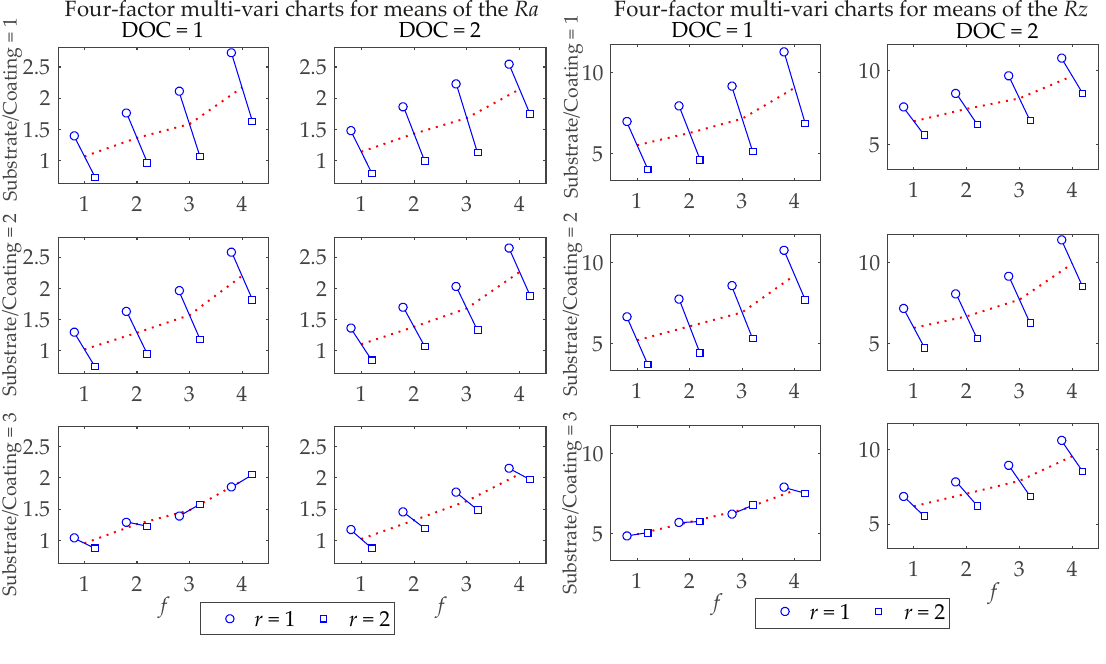
Figure 5. Four-factor multi-vari chart for Ra and Rz surface roughness means. Materials 2020 , 13 , x FOR PEER REVIEW